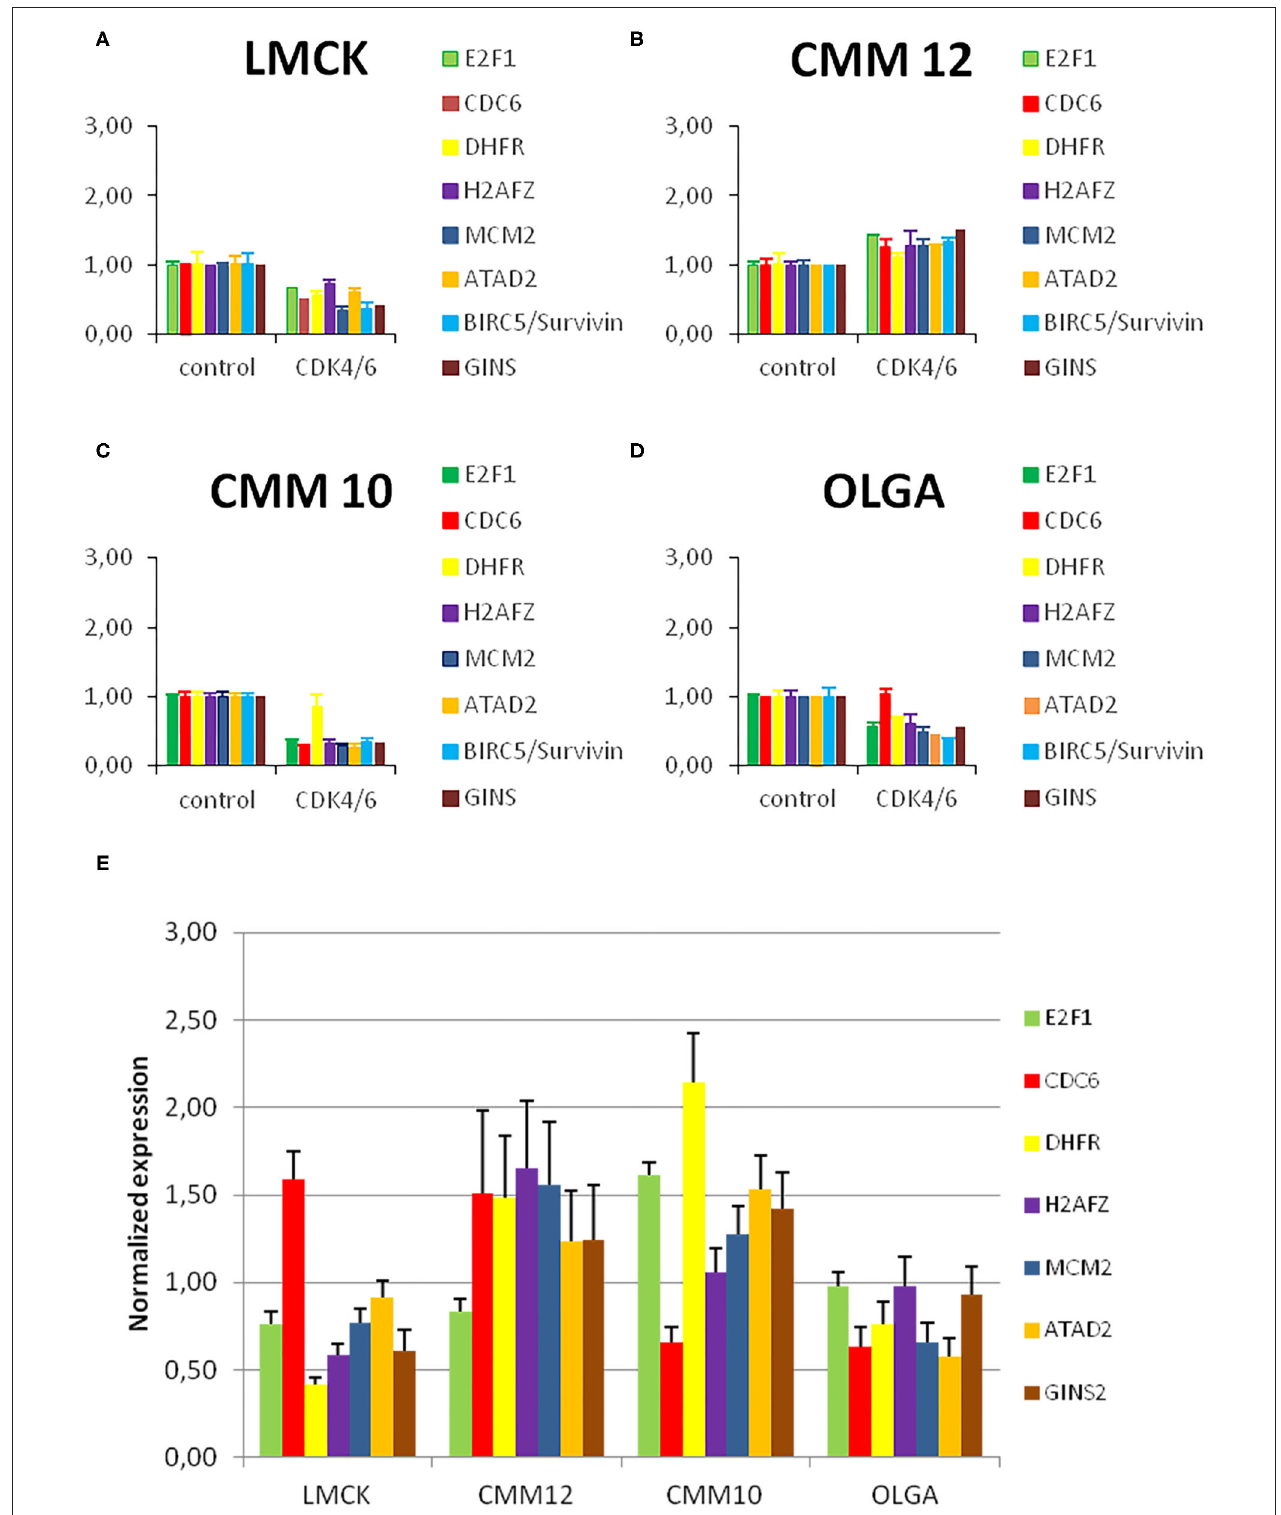
FIGURE 6 | Resistant melanoma cell line showed high levels of H2FZ before and after treatment with CDK4/6 inhibitor. (A–D) E2F target gene expression in melanoma cells before and after treatment with a CDK4/6 inhibitor. Normalized E2F target gene transcript levels in melanoma cells treated with 1 µ M